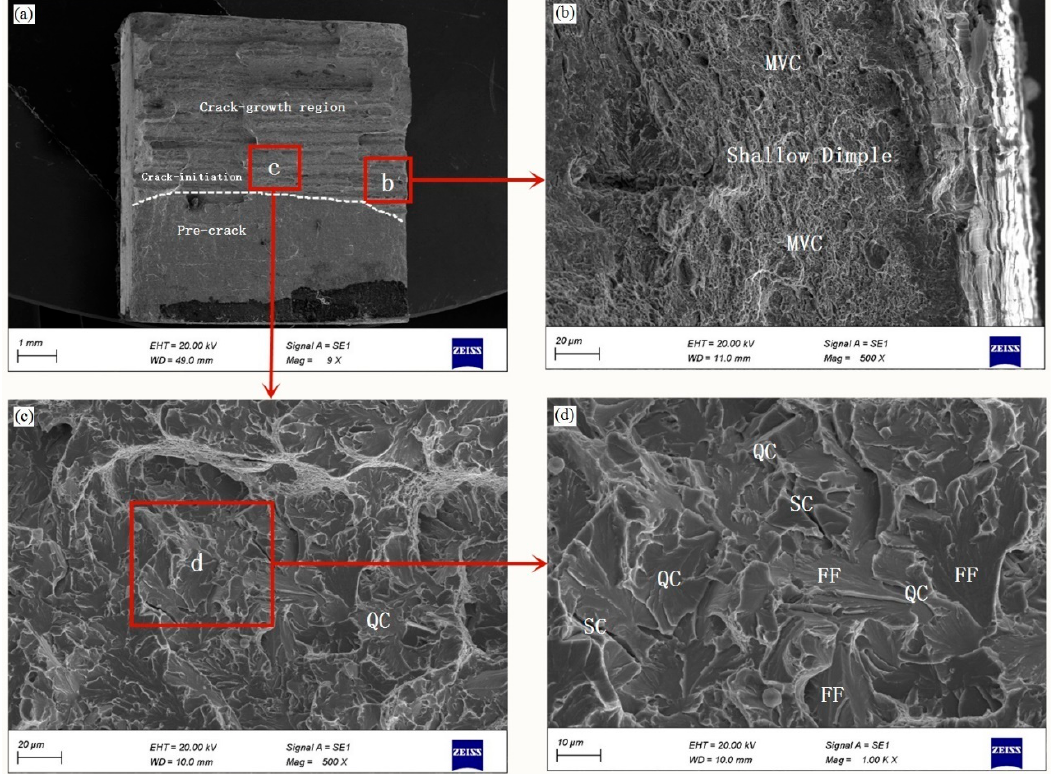
Figure 5. SEM images of the fracture surface of specimen charged for 12 h, and ( a ) overview of the fracture surface; ( b , c ) High magnification SEM images of the indicated region in image ( a ); ( d ) High magnification SEM image of the indicated region in image ( c ); QC: quasi-cleavage; MVC: micro-void coalescence; FF: flat facet, SC: secondary crack.